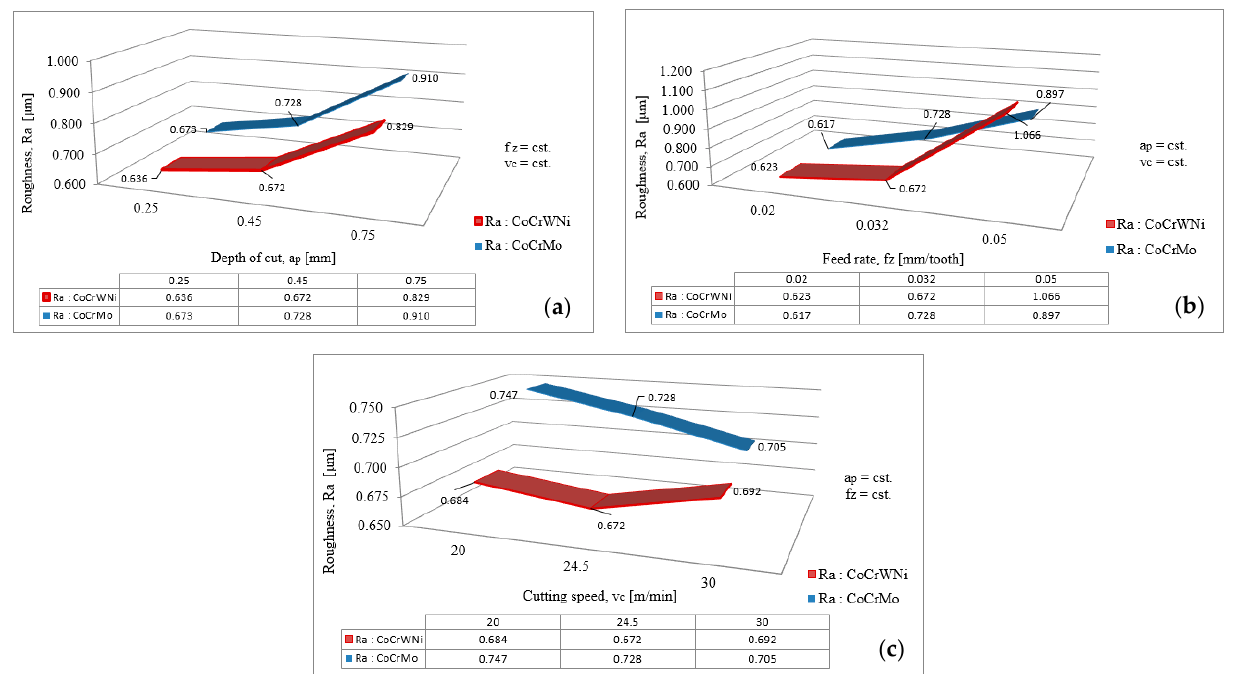
Figure 6. Variation of Ra roughness in relation to the milling process variables: ( a ) variation of surface roughness, Ra, in relation to the axial depth of cut, a p ; ( b ) variation of surface roughness, Ra, in relation to the feed rate per tooth, f z ; ( c ) variation of surface roughness, Ra, in relation to the cutting speed, v c